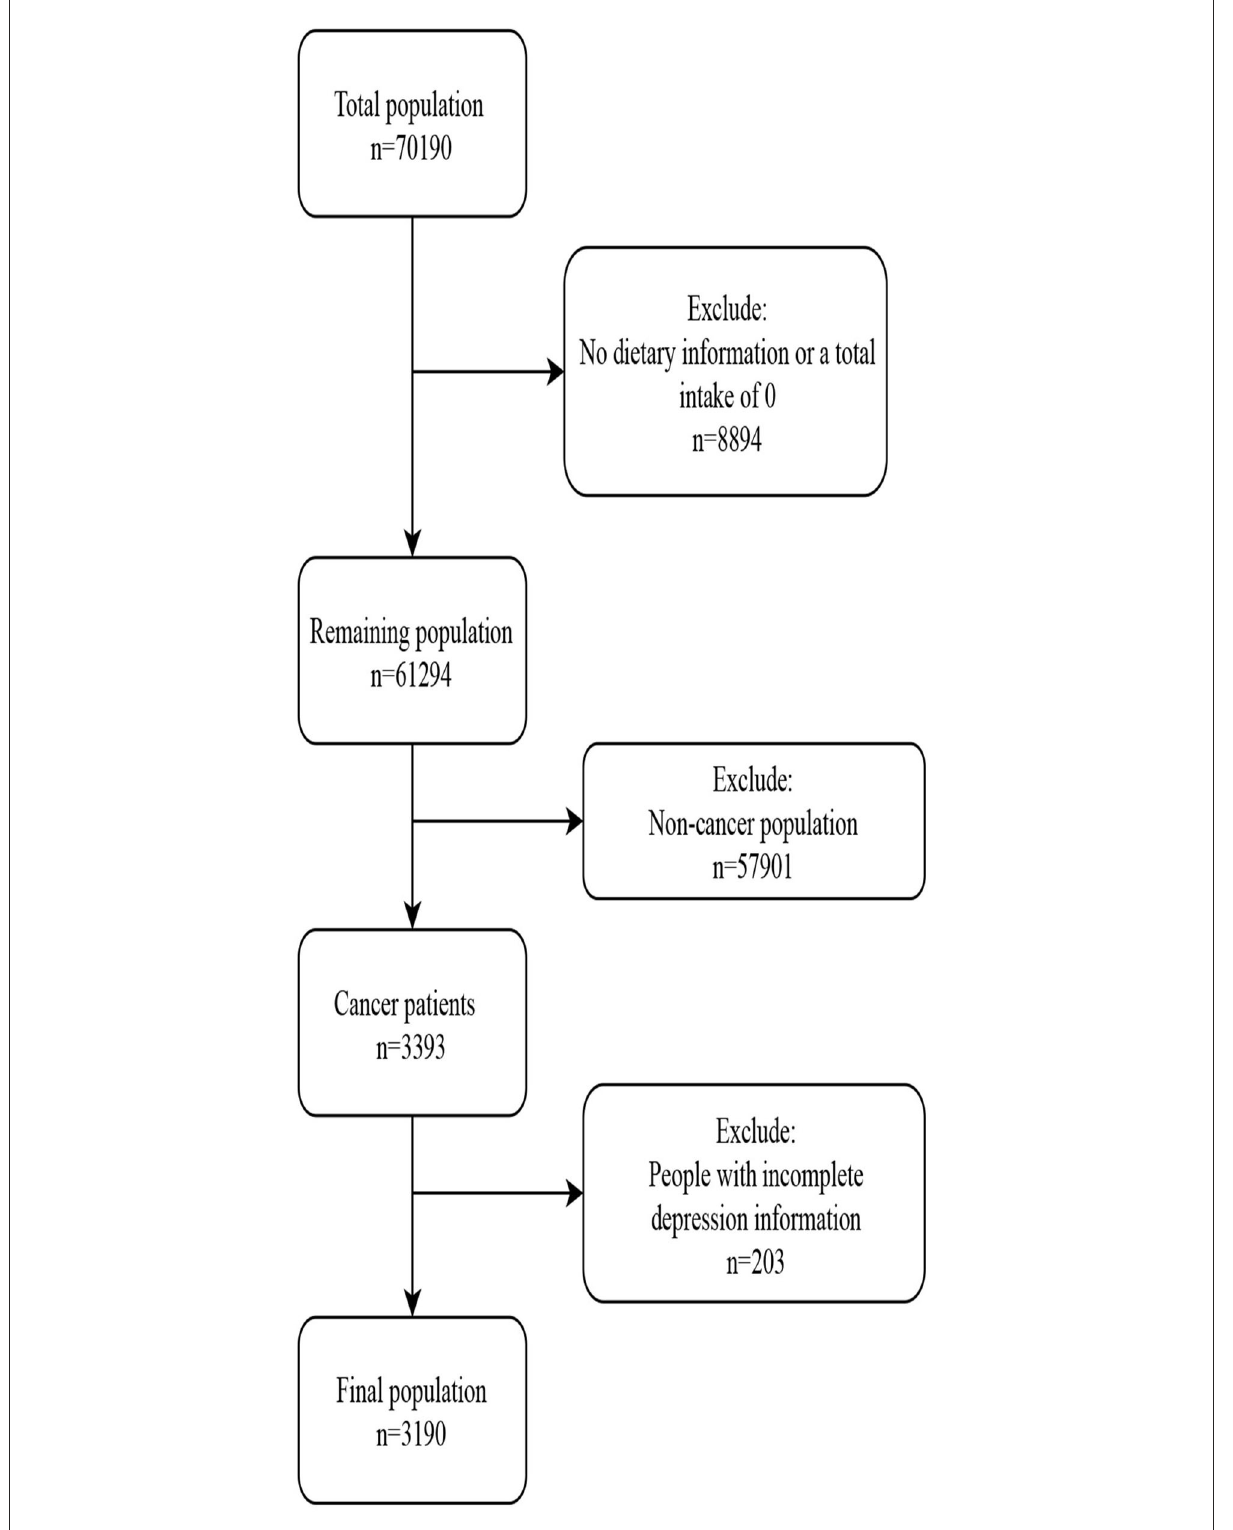
FIGURE1 Flow chart of data collection and population inclusion